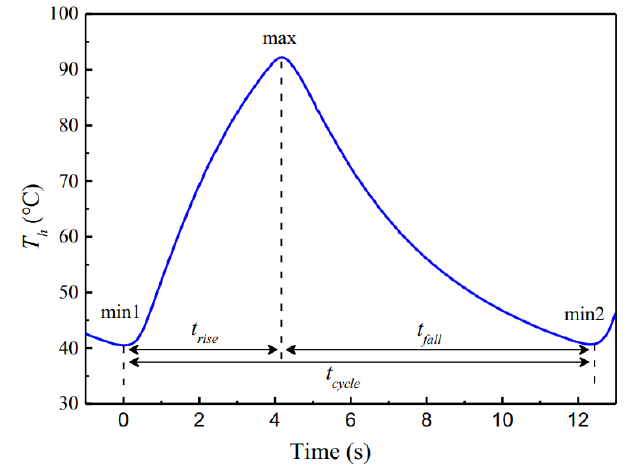
Figure 9. Illustration of a typical heat cycle.